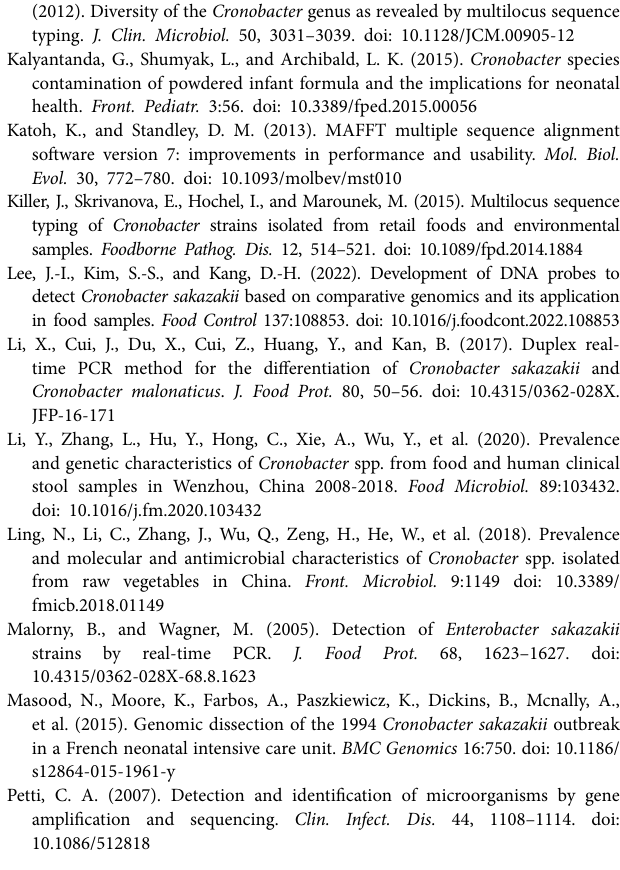
Supplementary Figure S1 | Design of PCR primers based on genus- and species-specific genes. Primer positions and directions are indicated as red arrows; genes lengths are indicated as black lines; variable and conserved (from magenta to purple) nucleotide positions are highlighted in the color stripe. Supplementary Figure S2 | Large-scale BLAST score ratio (LS-BSR) analysis of Cronobacter sakazakii specific marker genes fimG (A) and nanK (B) . (a) BSR value distribution of target marker genes in C. sakazakii , (b) BSR value distribution of target marker genes in the other six species of Cronobacter , and (c) BSR value distribution of target marker genes in other bacteria. Supplementary Figure S3 | Large-scale BLAST score ratio (LS-BSR) analysis of C. malonatious specific marker genes papD (A) and sthD (B) . (a) BSR value distribution of target marker genes in Cronobacter malonaticus , (b) BSR value distribution of target marker genes in the other six species of Cronobacter , and (c) BSR value distribution of target marker genes in other bacteria. Supplementary Figure S4 | Large-scale BLAST score ratio (LS-BSR) analysis of C. turicensis specific marker genes phpB (A) and nudI (B) . (a) BSR value distribution of target marker genes in C. turicensis , (b) BSR value distribution of target marker genes in the other six species of Cronobacter , and (c) BSR value distribution of target marker genes in other